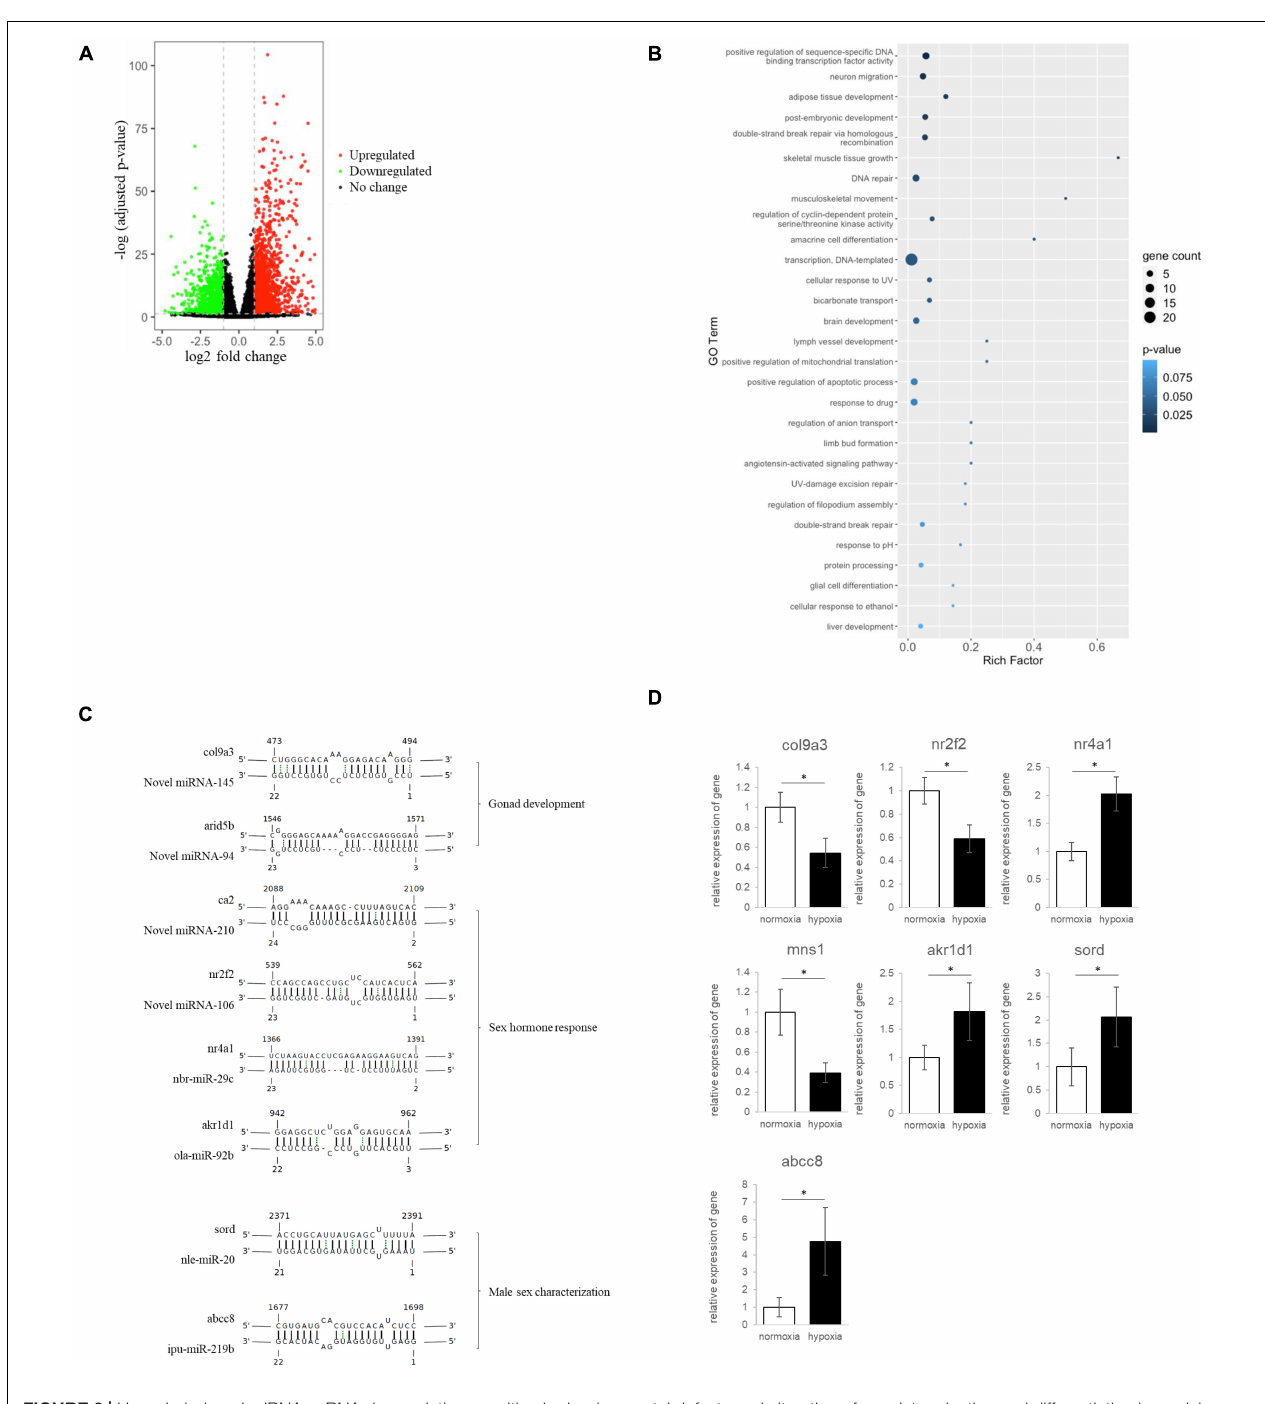
FIGURE 3 | Hypoxia-induced miRNA–mRNA dysregulation, resulting in developmental defects and alteration of sex determination and differentiation in medaka embryos. (A) Volcano plot showing differential mRNA expression in embryos after hypoxia or normoxia exposure. mRNAs with | log2 (fold change: hypoxia/normoxia)| > 1 and –log B&H corrected p -value > 1.3 were considered differentially expressed. Red dots represent upregulated mRNA, green dots represent downregulated mRNA, and black dots represent mRNA with no significant change. (B) Rich factor plots showing the biological processes altered by the miRNA–mRNA pairs using Gene Ontology (GO) enrichment analysis of Database for Annotation, Visualization and Integrated Discovery (DAVID). Dot size represents the number of genes. The color intensity of each dot represents the significance of the biological process. (C) Hypoxia-dysregulated miRNA–mRNA pairs related to gonad development, sex hormone response, male sex characterization. The complementary sequence shows the interaction between miRNA and mRNA. (D) Quantitative PCR validated the differential gene expression in embryo after the hypoxia exposure. ∗ Represented a statistically significant different of gene expression between normoxia and hypoxia